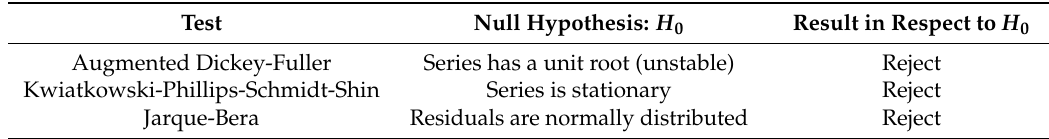
Table 2. Statistical tests applied to the original load series.